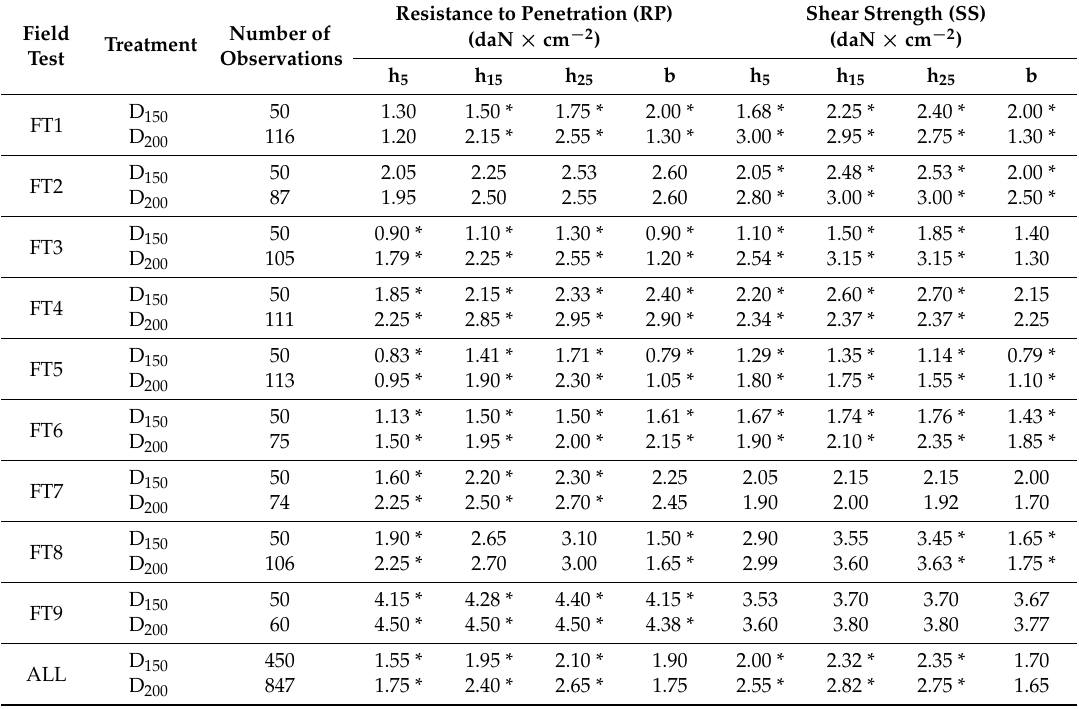
Table 4. Description and comparison of resistance to penetration (RP) and shearing strength (SS) between field tests and drill